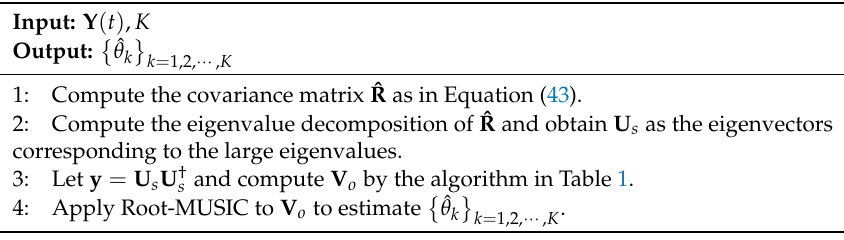
Table 3. The DOA estimation algorithm via